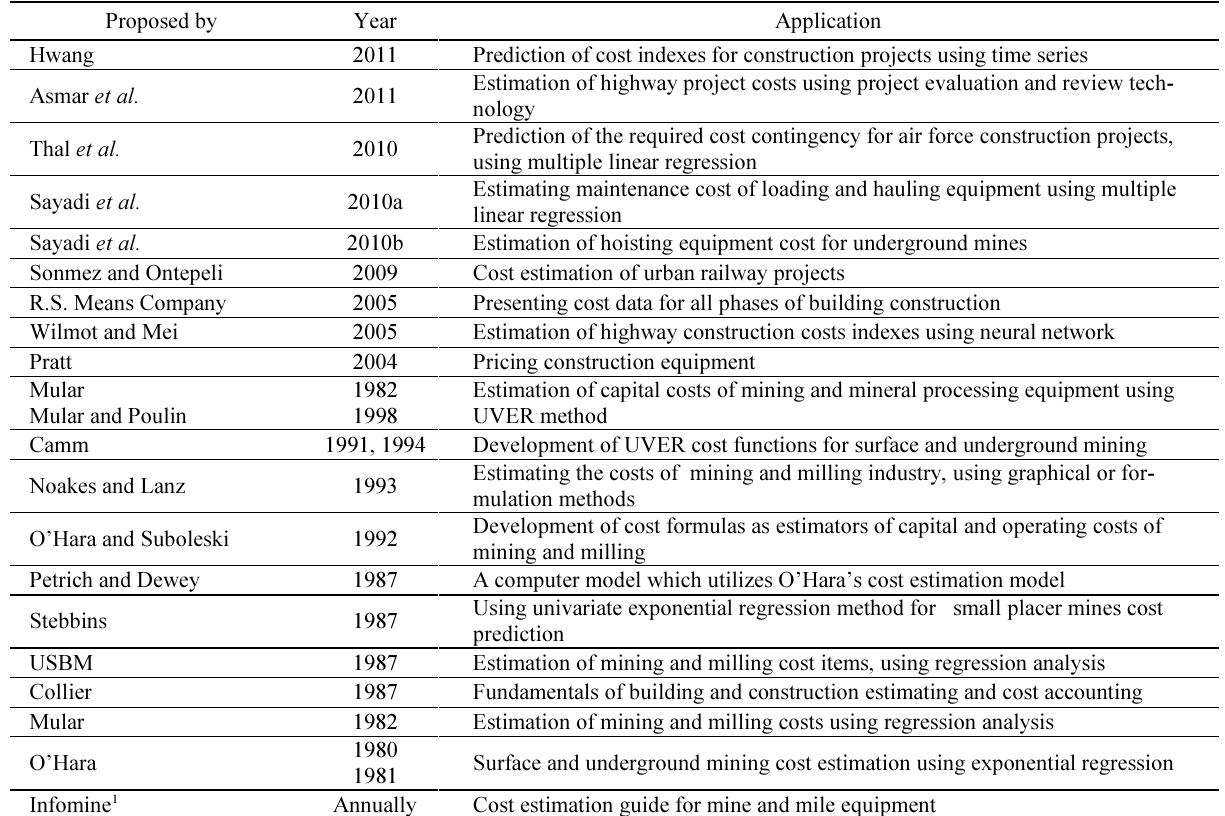
Table 1. The various applications of construction and mining cost estimation Proposed